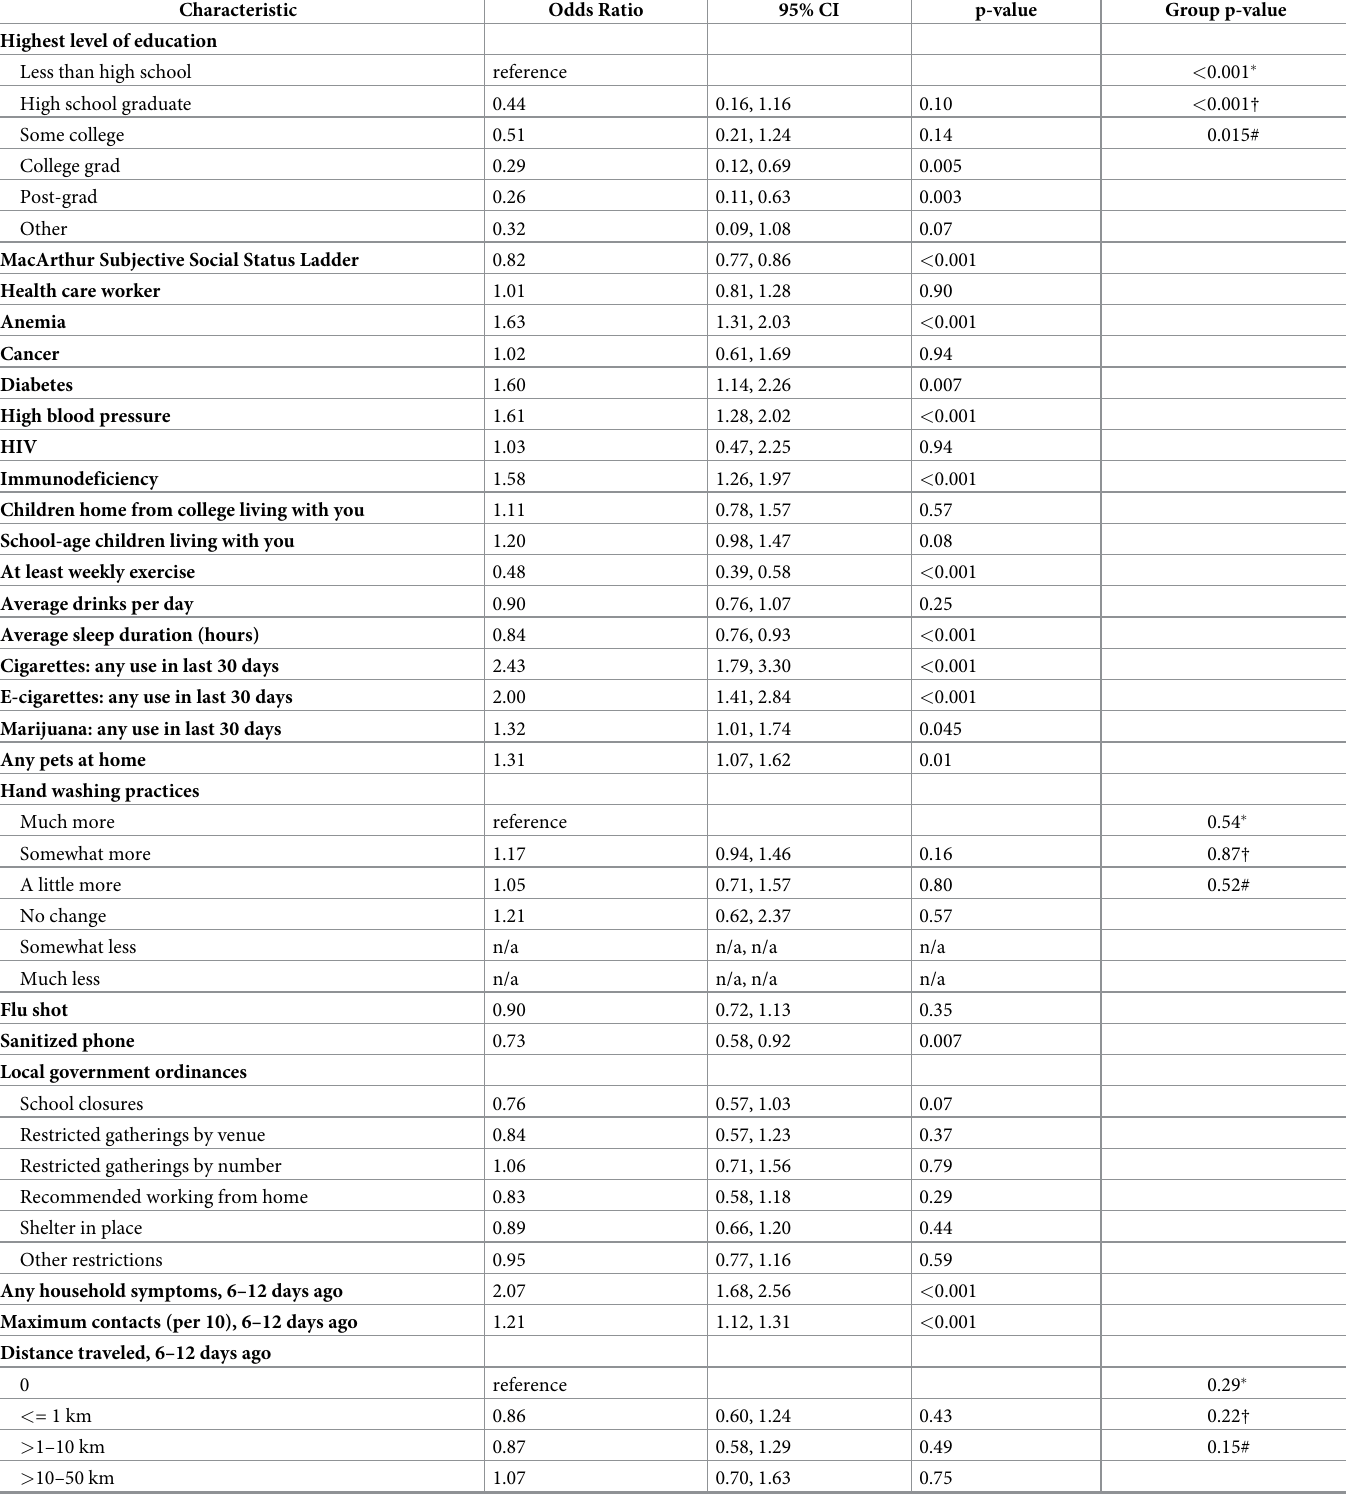
Table 2. Minimally adjusted odds of incident symptoms.